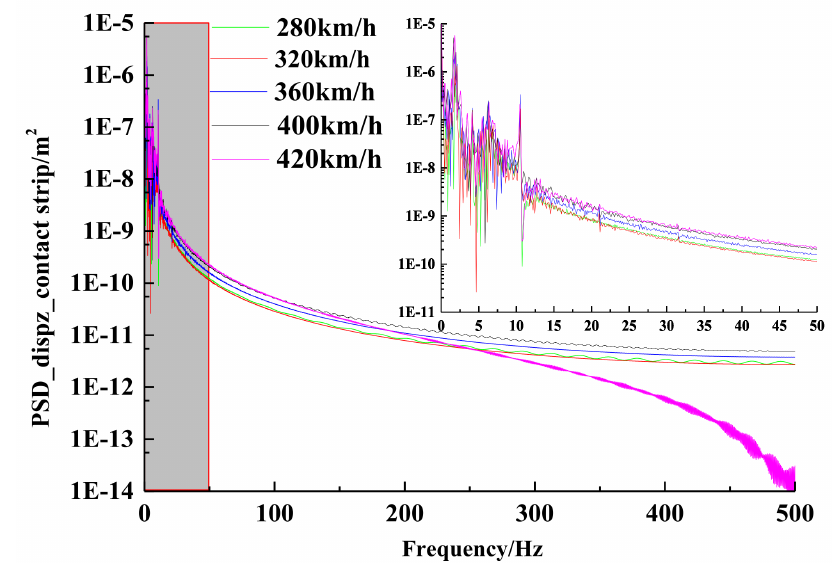
Figure 16. Power spectral density curves of vertical displacement of the contact strip passing through tunnel at different speeds.